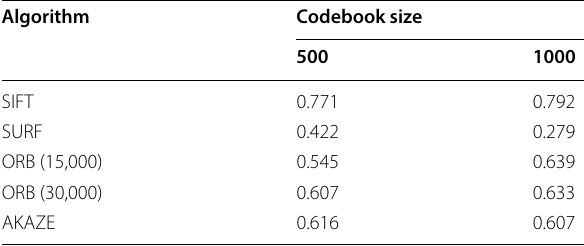
Table 2 F1-scores of wood recognition models established using local features detected by the SIFT, SURF, ORBs, and AKAZE